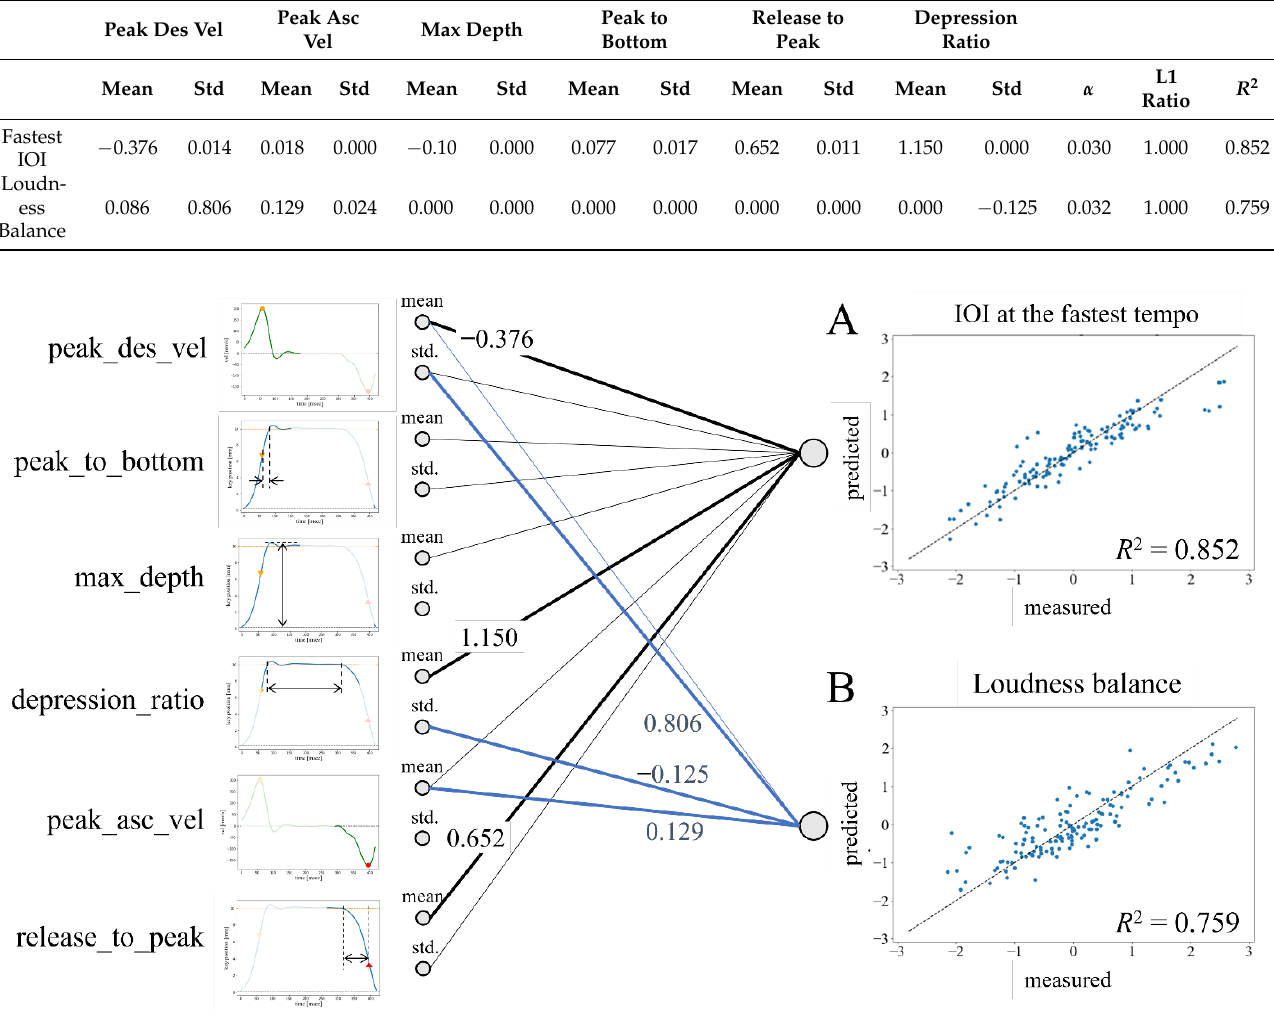
Figure 4. Schematics of the results of the penalized regression explaining the interindividual variance of each of the IOIs at the fastest tempo and loudness balance across the participants. ( A ) R 2 of